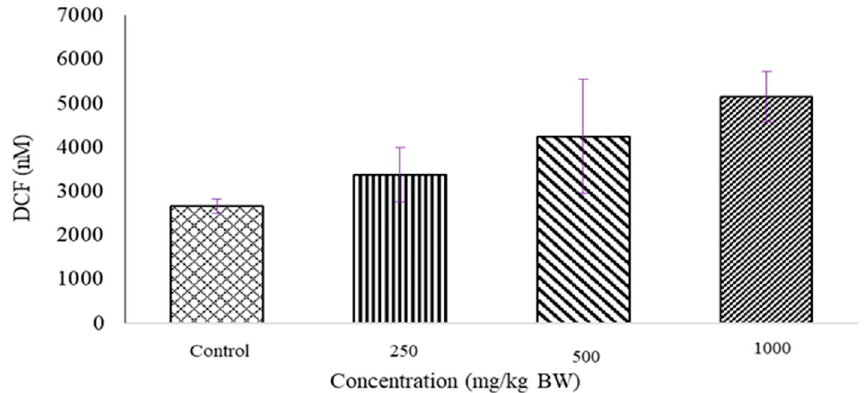
Figure 2. Production values of ROS in placenta tissues of pregnant rats treated with D. hispida aqueous extract at 250, 500 or 1000 mg/kg BW body weight for 15 days. Values of ROS based on the intensity of 2 (cid:48) ,7 (cid:48) -Dichlorodihydrofluorescein (DCF) were expressed as mean ± SEM ( n = 5) ( p > 0.05). 2.3. Lipid Peroxidation and Malondialdehyde (MDA) Quantification